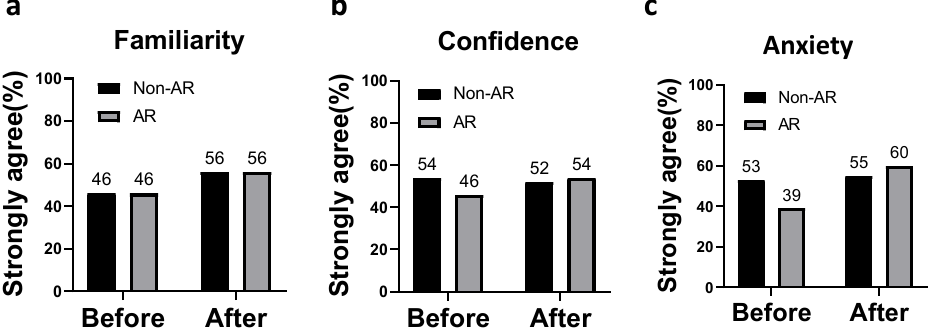
Figure 3. The distribution of both group’s inspiratory flow rate at different time points.